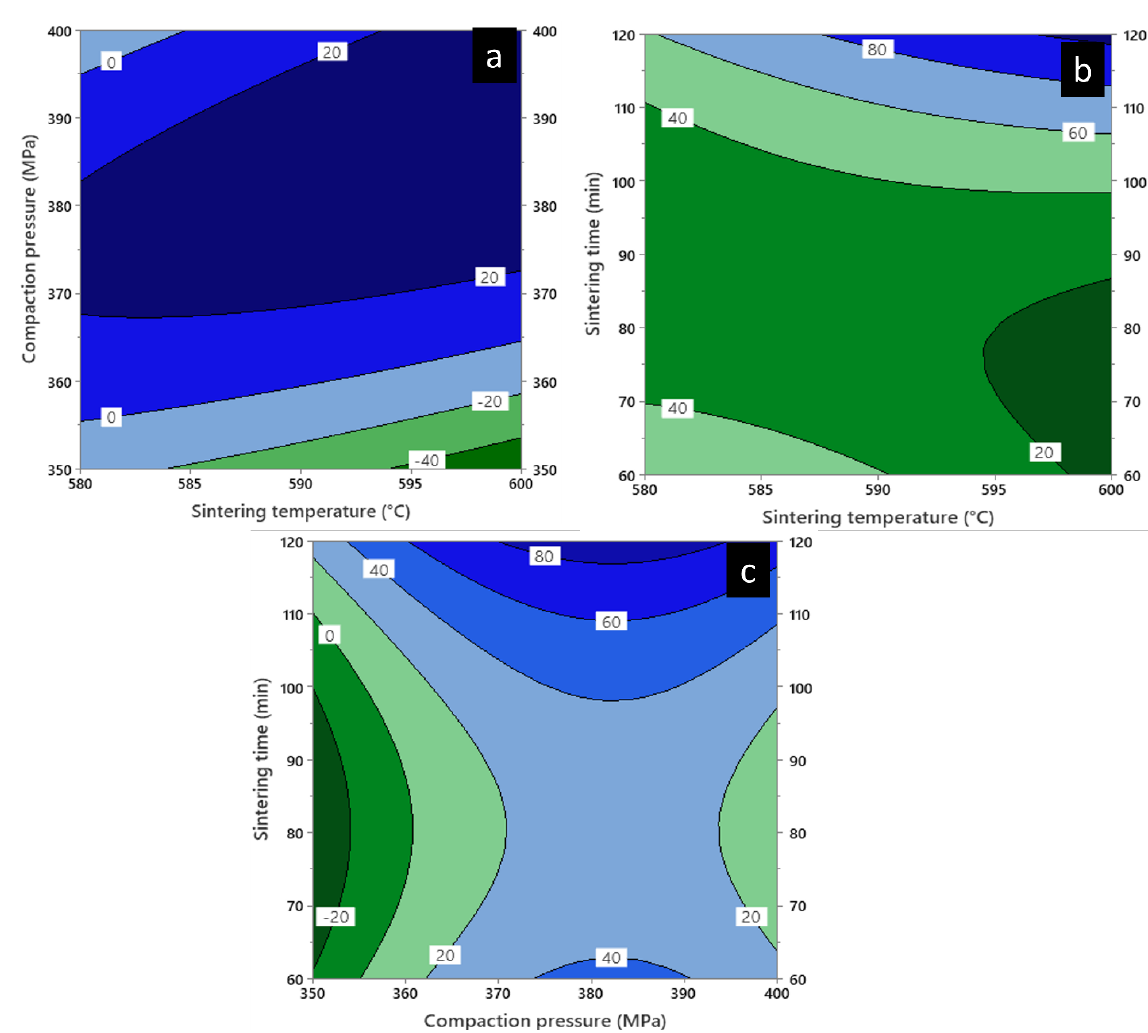
Figure 14. Contour plot of energy absorption capacity of diamond-reinforced porous Al composites showing, ( a ) Compaction pressure vs. sintering temperature, ( b ) Sintering time vs. sintering temperature and ( c ) Sintering time vs. compaction pressure.